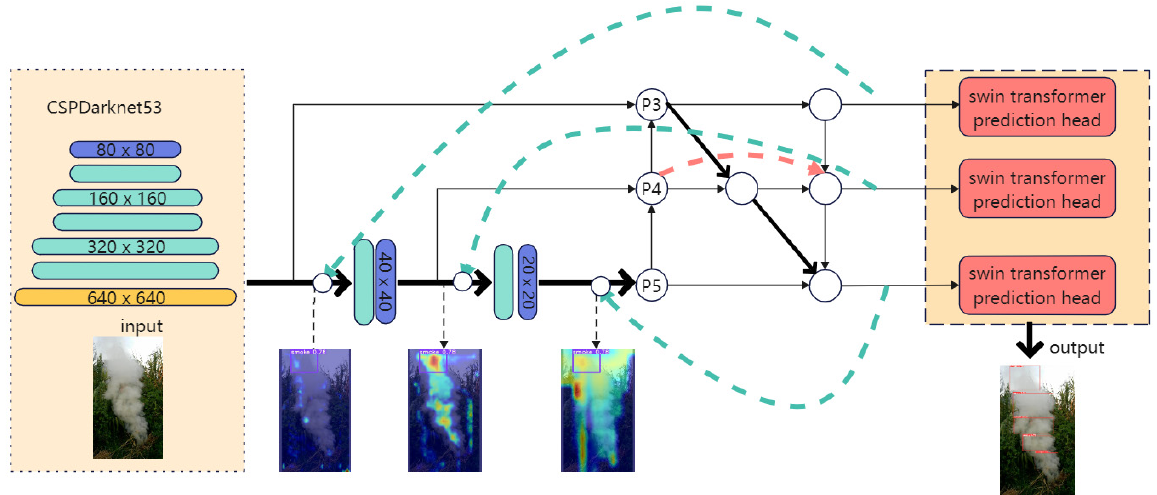
Figure 2. Structure of the proposed wildfire smoke detection network. The backbone network is CSPDarknet53 framework of YOLOV5, and Recursive BiFPN is designed for feature fusion and enhancement, and Swin Transformer for classification. The green dashed arrow indicates that the feature will be iterated back to the original backbone network once after being processed by BiFPN, and fused with the feature of the corresponding size, and then continue the subsequent processing. It is worth mentioning that the iteration is performed only once.